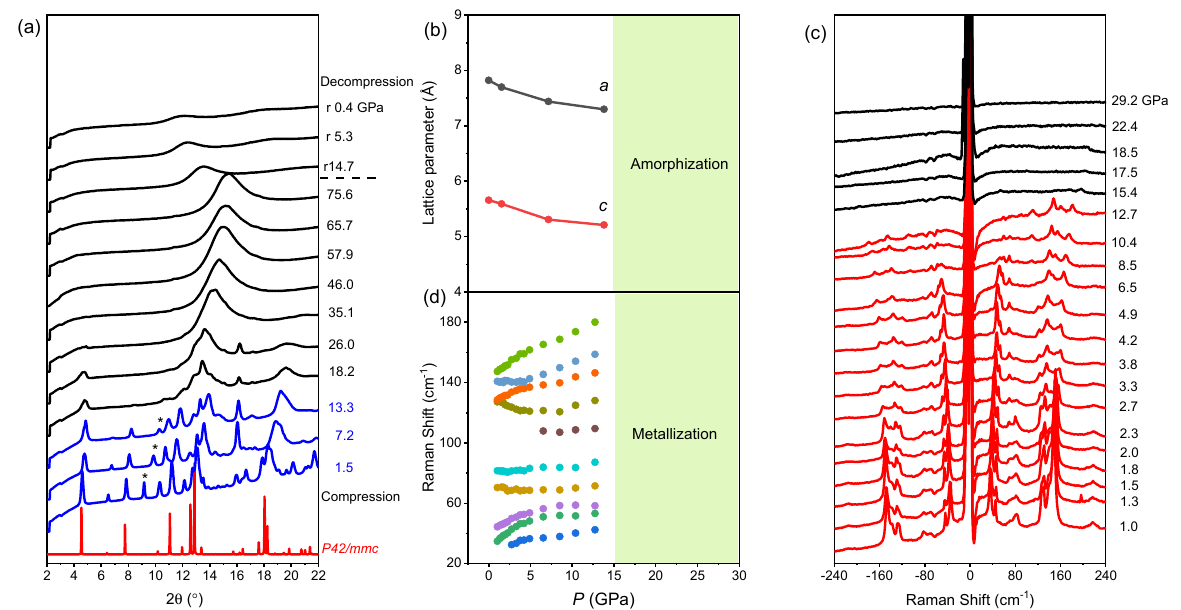
Figure 4. Pressure effect on structure of PdTeI. ( a ) XRD patterns of PdTeI measured at room temperature with increasing of external pressure up to 75.6 GPa. The X-ray diffraction wave-length λ is 0.6199 Å. ( b ) Pressure dependence of the lattice constants a and c for PdTeI. ( c ) Raman spectrum of PdTeI at various pressures. Anti-stokes shift and stokes shift of Raman shifts are symmetrical about 0 cm − 1 . ( d ) Stokes shifts of Raman spectroscopy for PdTeI in compression.